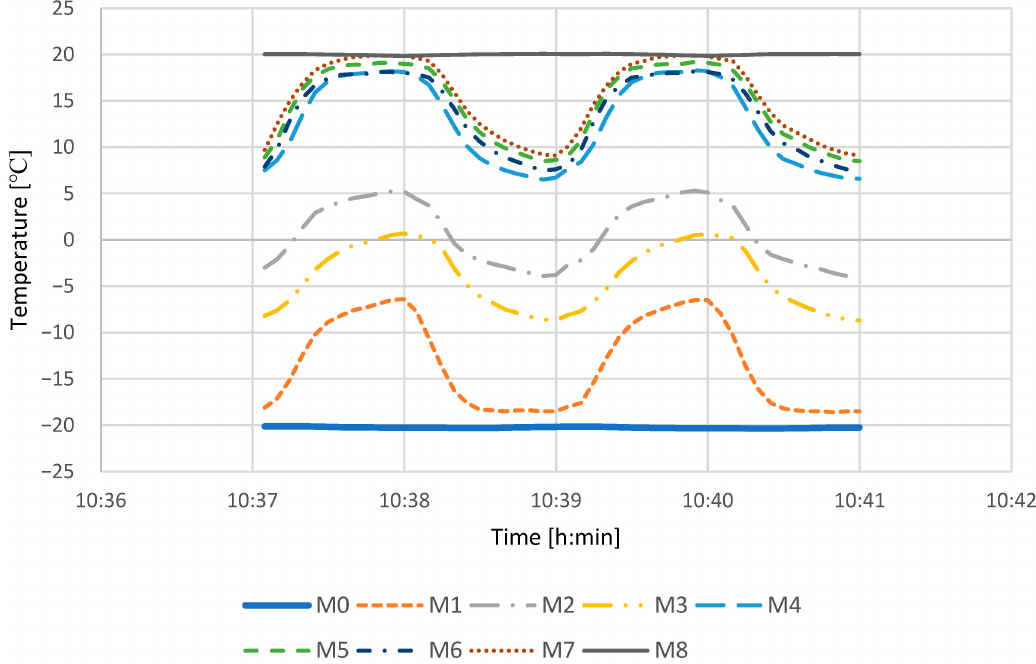
Figure 12. Change in temperature in measuring points marked M0–M8, when the first heat exchanger, filled with jojoba oil, was used. The external temperature equals − 20 ◦ C and internal temperature equals 20 ◦ C. The supply and exhaust cycles were 1 min. Temperature change